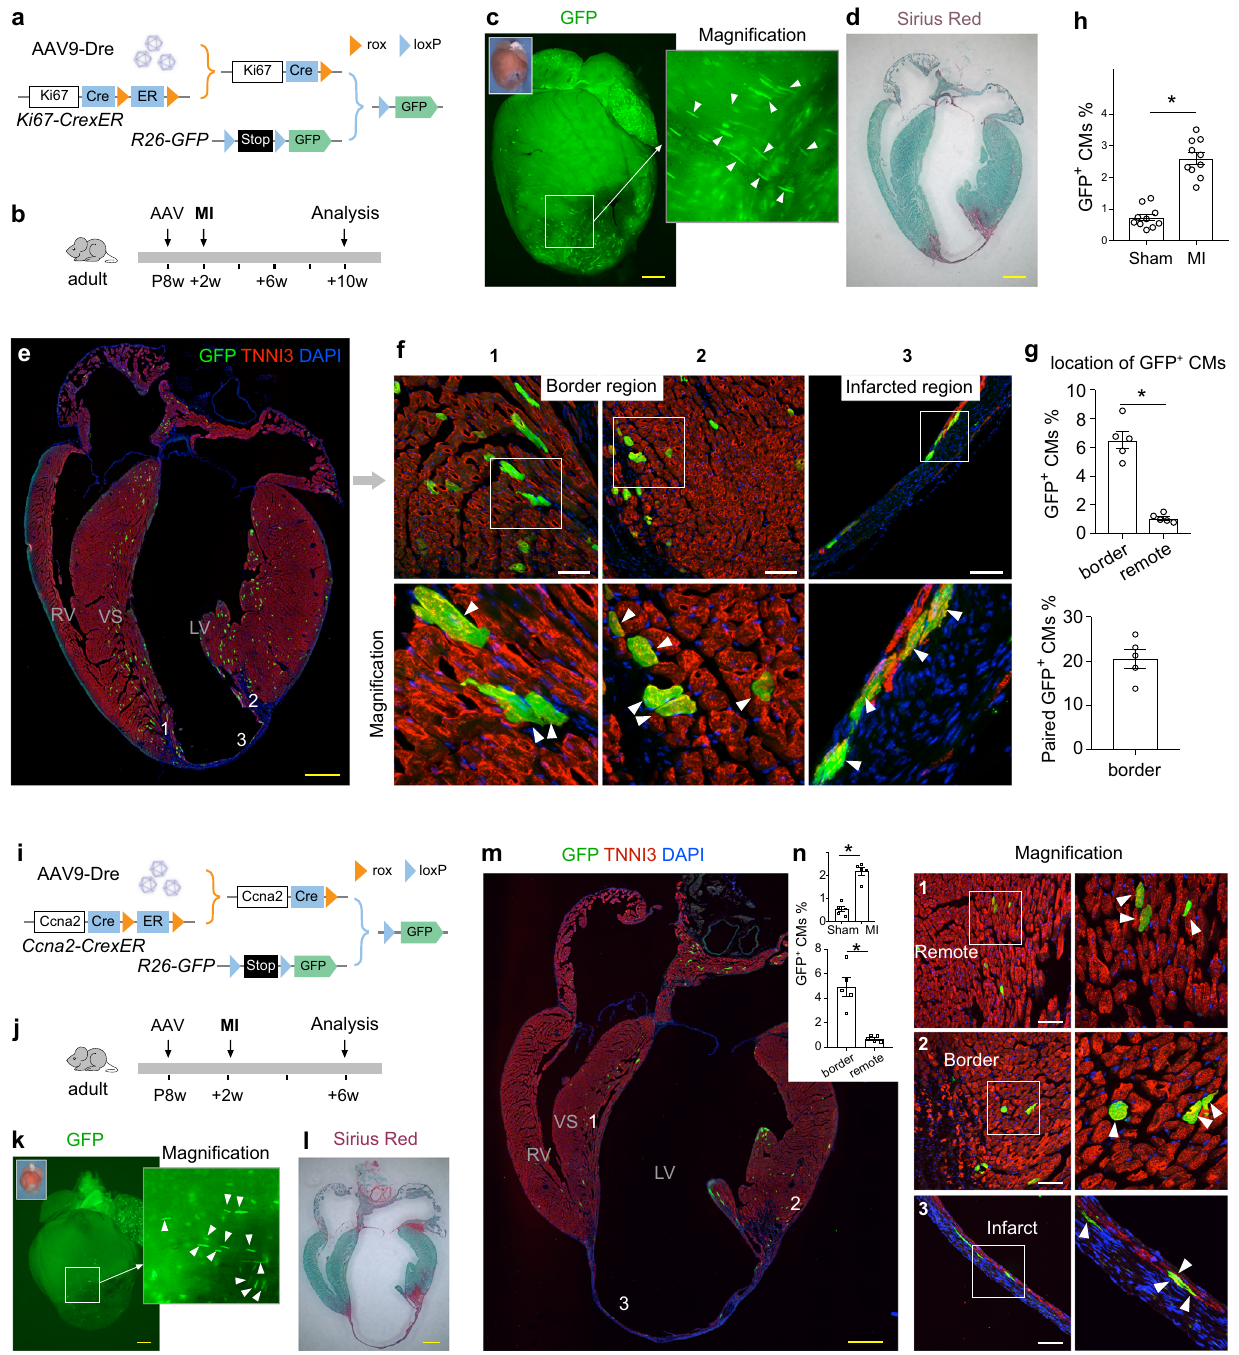
Fig. 7 Cardiomyocyte cell-cycle activity detected by ProTracer after myocardial infarction. a Schematic showing Ki67-based ProTracer system. b Schematic showing experimental design. c Whole-mount GFP fl uorescence of MI hearts. Magni fi ed image shows GFP + cardiomyocytes (arrowheads). d Sirius Red staining on MI heart sections. e , f Immunostaining for GFP and TNNI3 on MI heart sections. Regions 1, 2, 3 are magni fi ed on the right panels. Arrowheads, GFP + cardiomyocytes. g Quanti fi cation of GFP + CM percentage in different regions of the hearts and the percentage of paired GFP